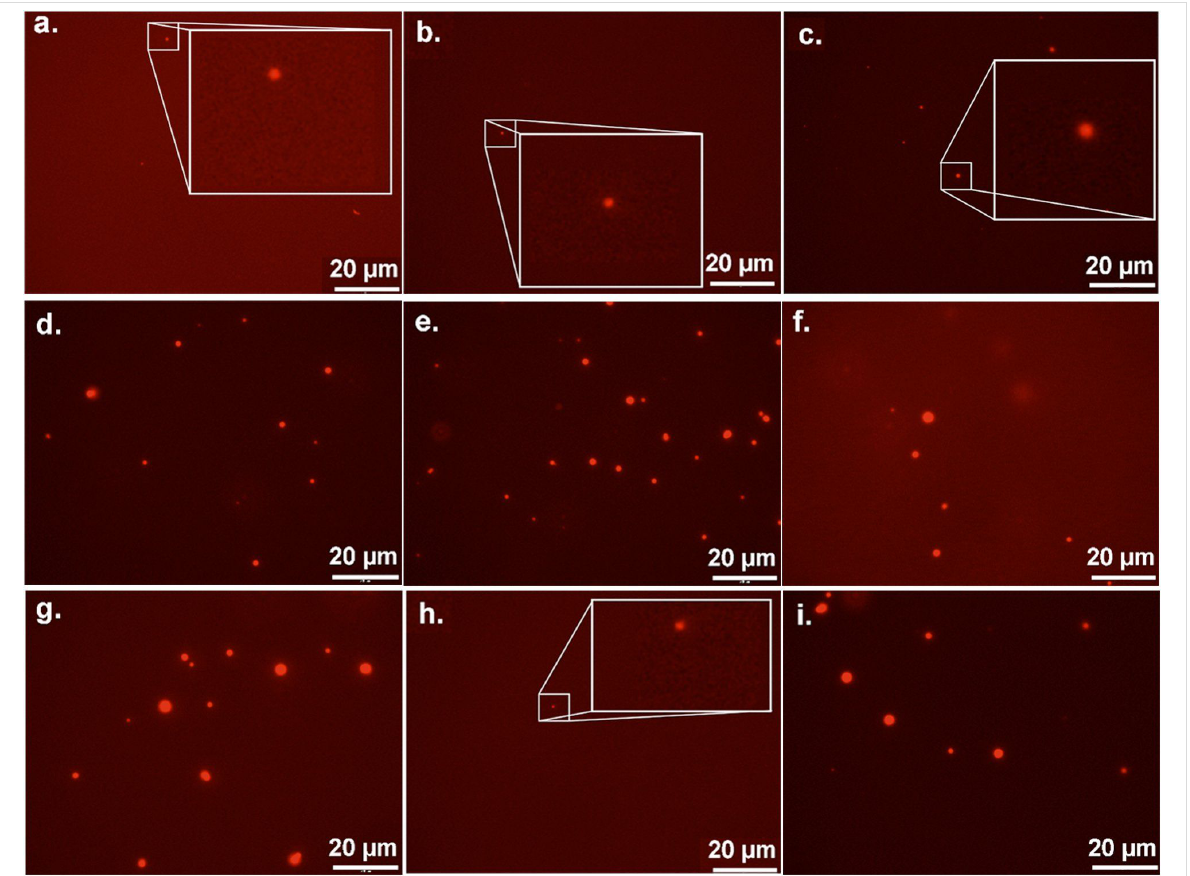
Figure 4: Representative fluorescent micrographs of glycodendrimer mediated galectin-1 nanoparticles. Nanoparticles formed with compounds (a) 2 , (b) 3 , and (c) 4 in a 220 molar excess of galectin-1 are shown in the top row and magnified by 4× for visualization. Nanoparticles formed with com- pounds (d) 2 , (e) 3 , and (f) 4 in a 9 molar excess of galectin-1 are shown in the middle row. In the bottom row, nanoparticles formed with compounds (g) 2 , (h) 3 (magnified by 4× for visualization), and (i) 4 in a 3 molar excess of galectin-1 are shown.